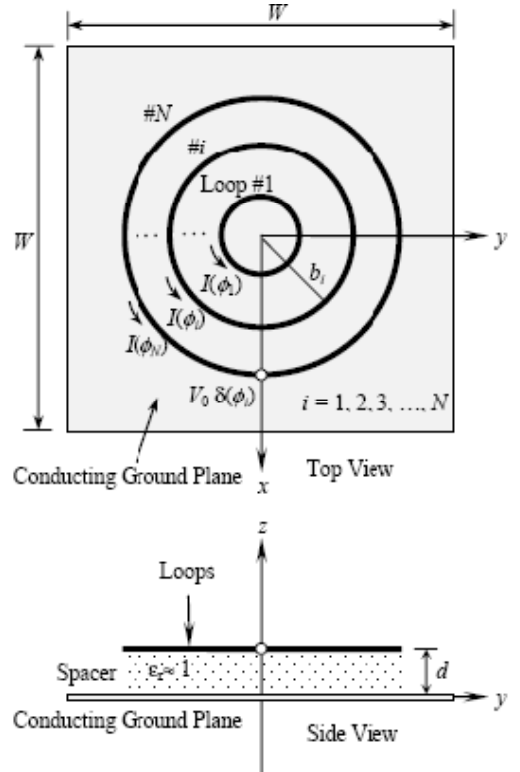
Figure 6: Geometry of the CCLA backed with a conducting ground